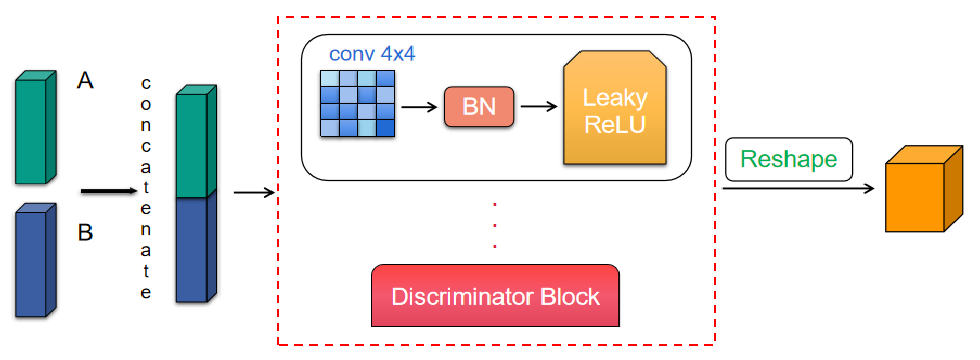
Figure 5. Discriminator, each discriminator block consists of conv, BN, LeakyReLU in series, where A is the original image and B is the result produced by the